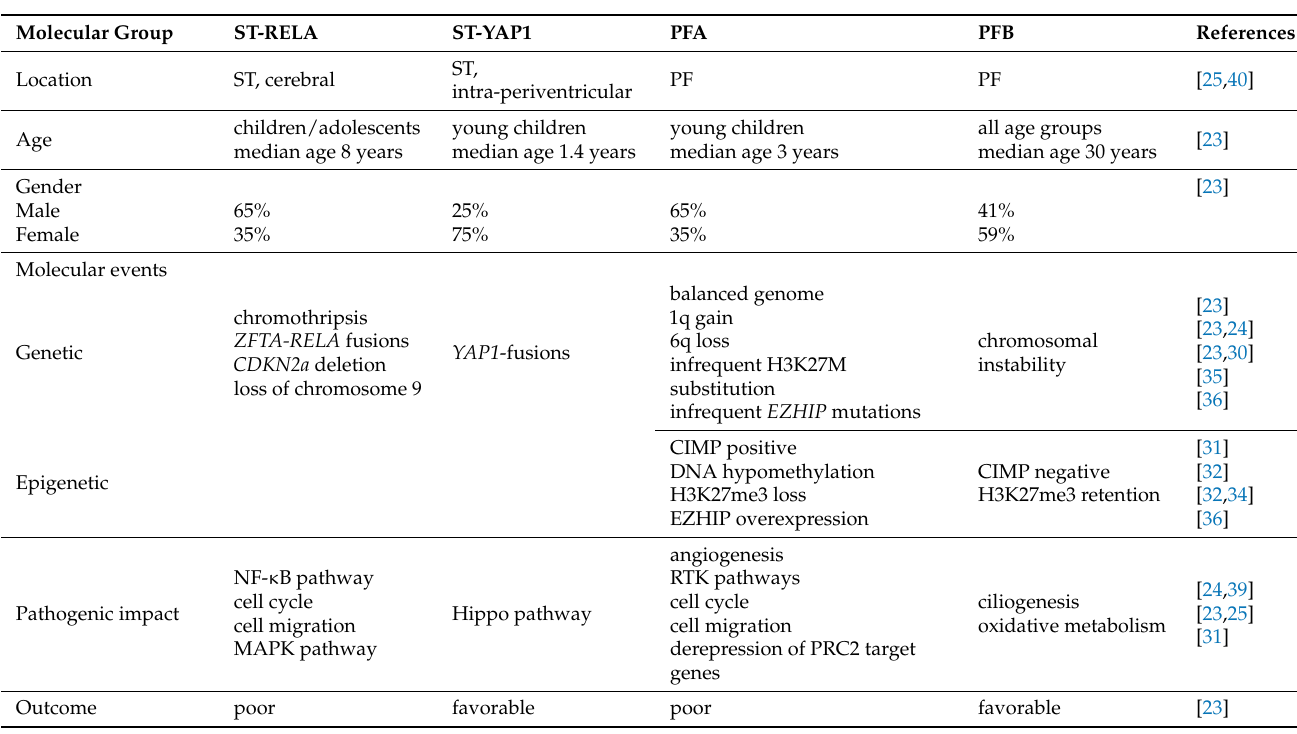
Table 1. Summary of the main genetic/epigenetic alterations and clinicopathological characteristics of the major groups of pediatric intra-cranial